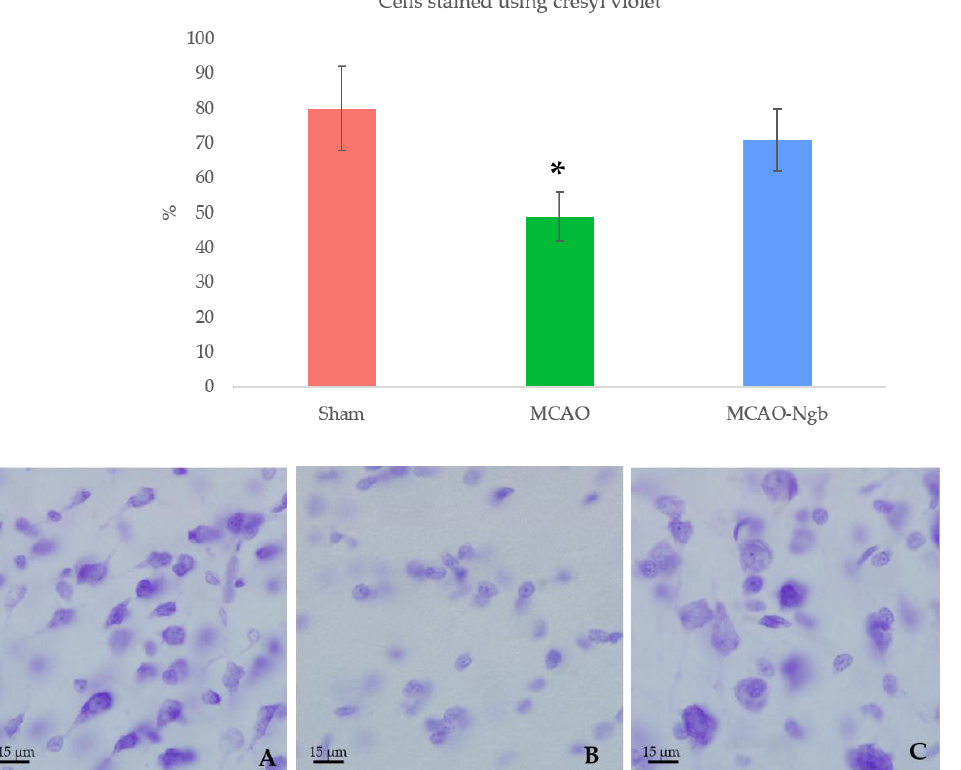
Figure 9. Upper panel: percentage of cells stained by cresyl-violet for each group: sham ( A ), MCAO ( B ), and MCAO-Ngb ( C ), measured using ImageJ. Animals from MCAO group show fewer neurons than rats from sham and MCAO-Ngb groups. Data are average values of 5 repetitions in 10 sections of 5 experimental animals in each group (* p < 0.05). Lower panel: representative microphotographs of the infarct zone (parietal cortex) of animals stained with cresyl-violet.